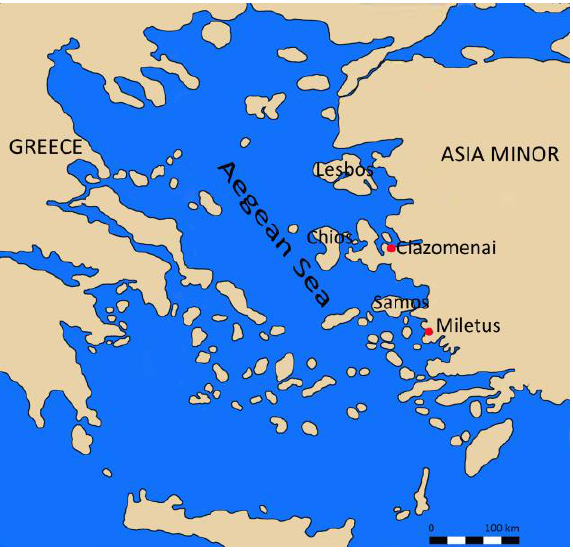
Figure 1. Ionian centers of amphora production in the Archaic Period